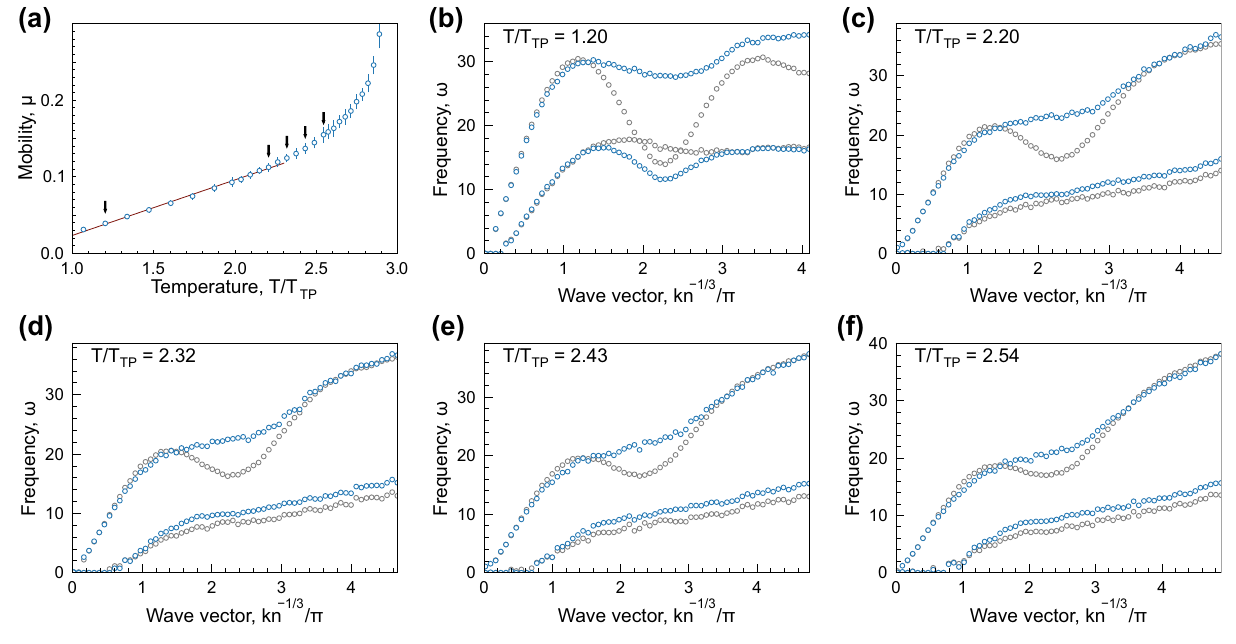
Figure 6. Particle mobility and dispersion relations: The results for LJ12-4 potential, description is the same as in Fig. 3.